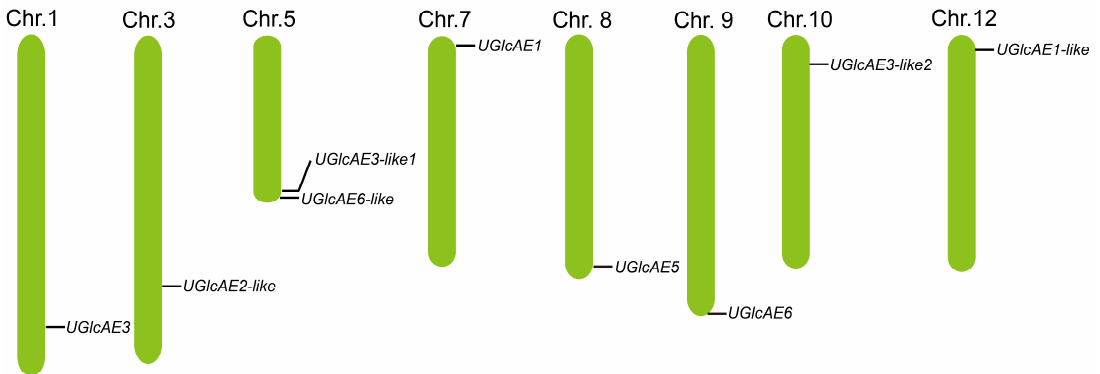
Figure 3. Chromosomal localization of the UGlcAE family genes in tomato. The numbers above each chromosome indicates the chromosome number.